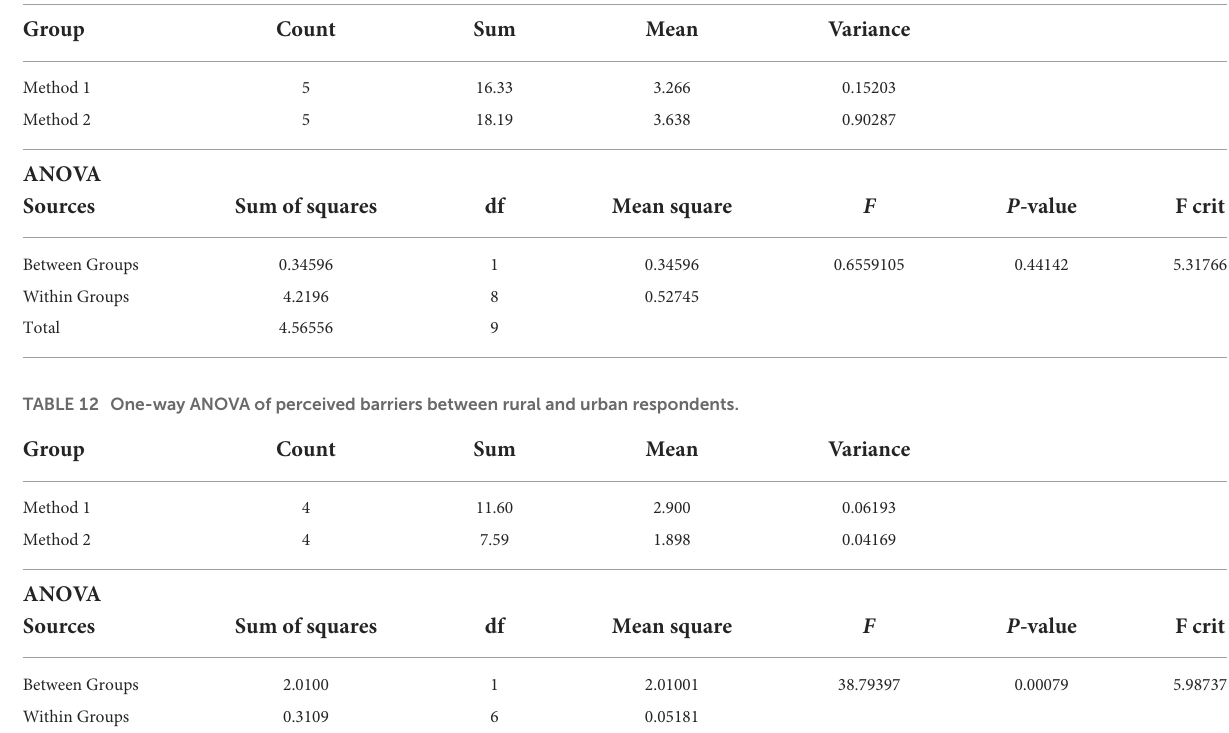
TABLE 11 One-Way ANOVA of perceived benefits between rural and urban respondents. Model summary